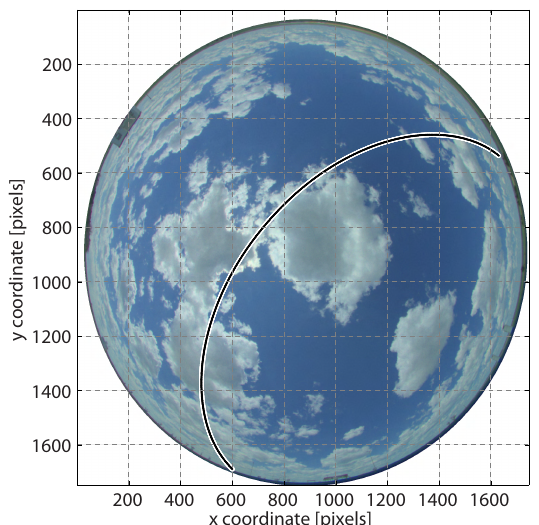
Figure 3. Synthetic data set point distribution. The 1673 points are generated from taking the solar position every 30s from sunrise to sunset on 13 May 2013, and projecting onto the image plane using a set of ground truth camera model parameters. The points shown are ground truth with no noise added. Background image (for visual reference only) is from 3 May